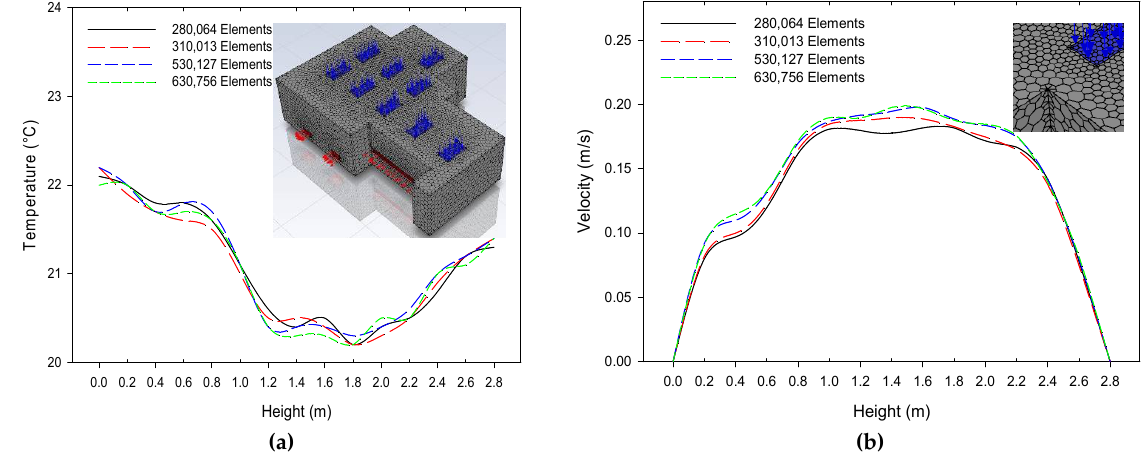
Figure 5. Mesh independence test of the investigated cleanroom; ( a ) temperature; ( b ) velocity.